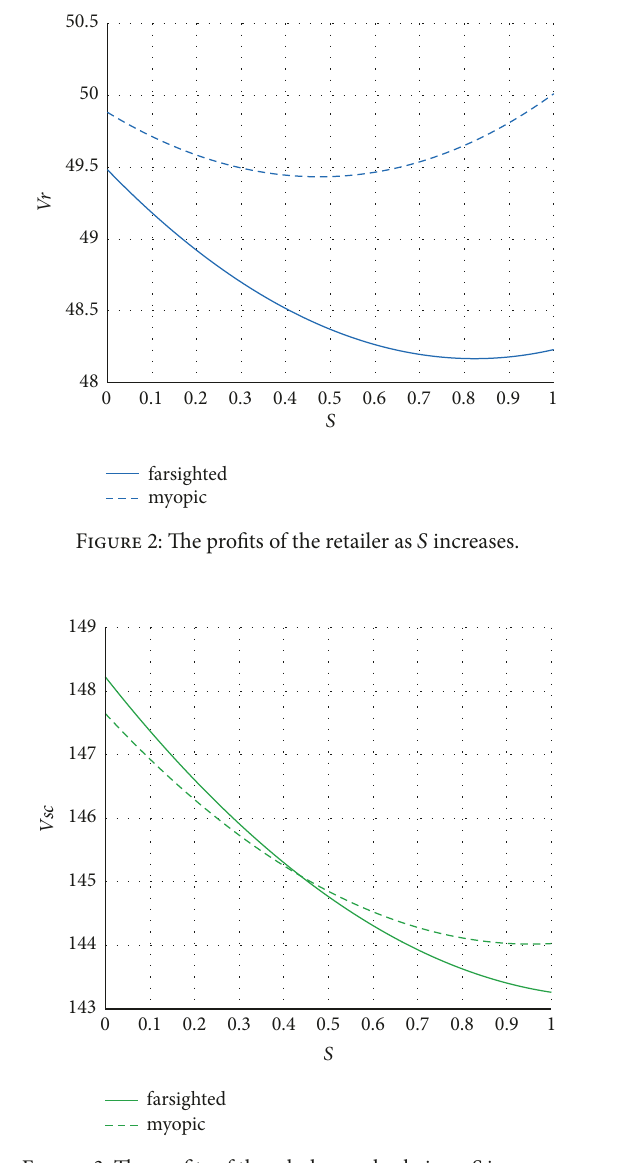
Figure 3: The profits of the whole supply chain as 𝑆 increases.